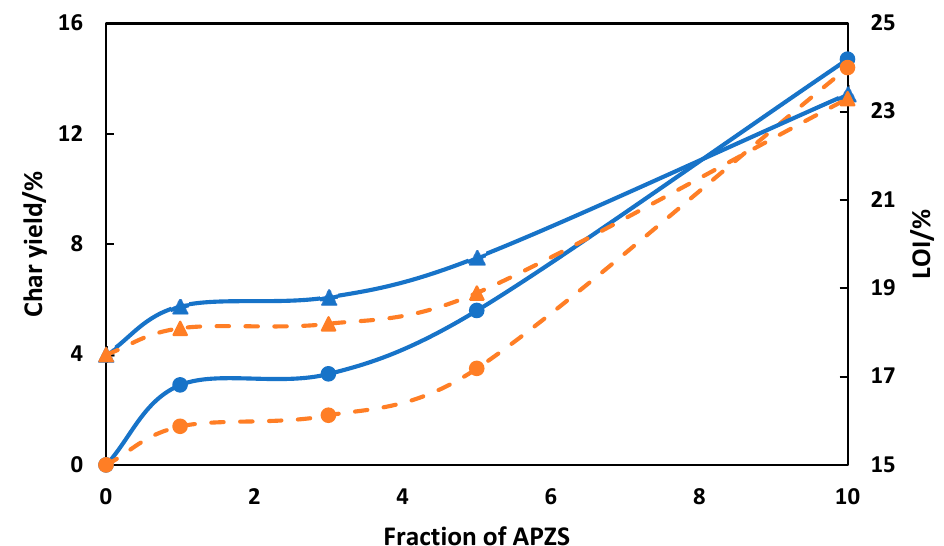
Figure 10. Thermal stability and flame retardancy of PP/phosphazene composites as a function of phosphazene concentration: Char yield ( ● ) and LOI ( ▲ ) in air (dash orange) and nitrogen (solid blue) atmosphere [134].